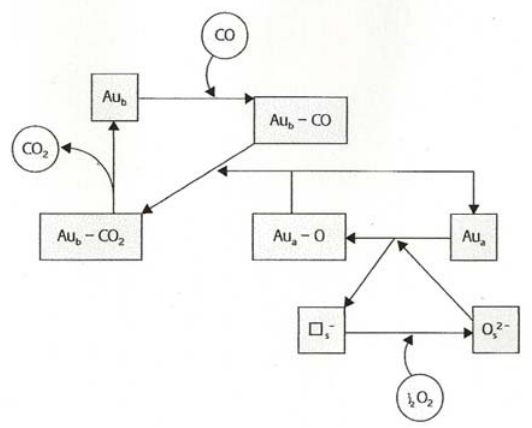
Figure 8. Example of a catalytic cycle: CO oxidation by the Mars-van Krevelen mechanism [34]. Encircled molecules are reactants and products; species shown in boxes are on the